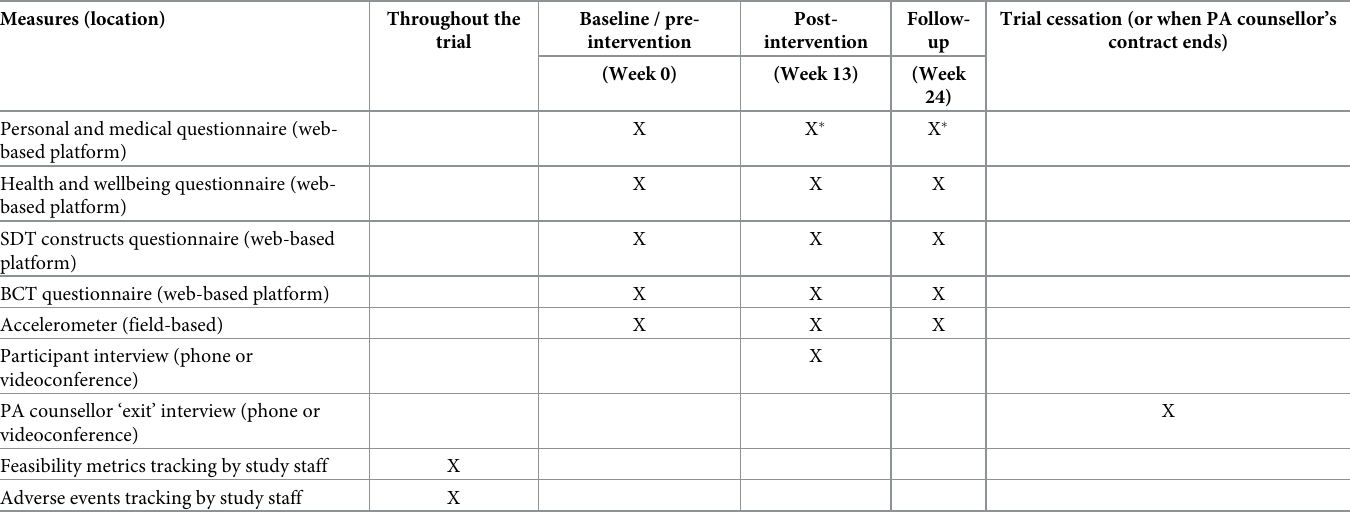
Table 1. Schedule of assessments and